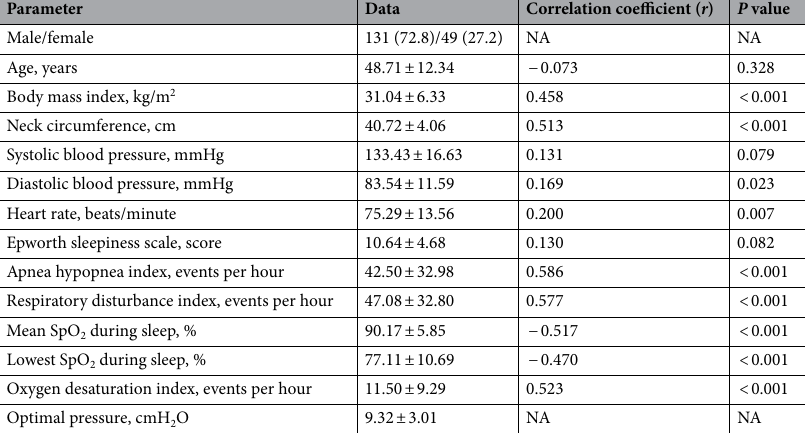
Table 1. Correlations between the optimal pressure and baseline characteristics, and polysomnographic parameters in 180 patients with obstructive sleep apnea. Data shown as mean ± SD or n (%). NA Not applicable, SpO 2 Pulse oxygen